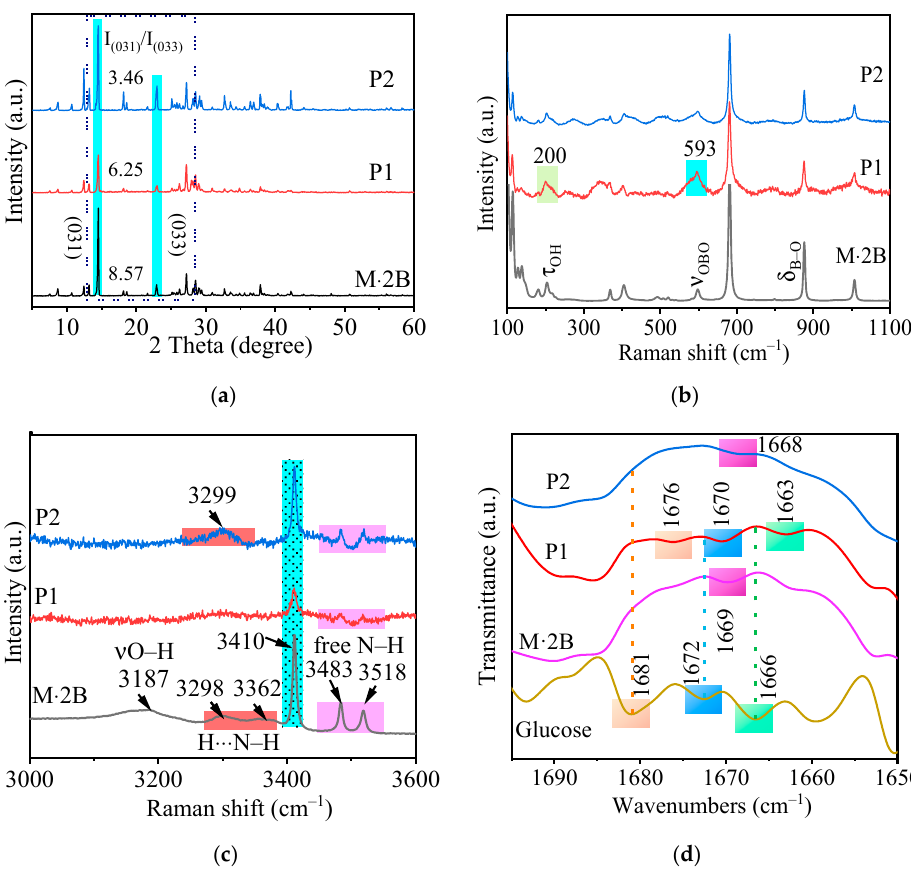
Figure 1. ( a ) Powder XRD patterns. ( b , c ) Raman spectra in the different wavenumber range. ( d ) An enlarged view of the FTIR spectra in the range of 1700~1650 cm − 1 for glucose, M·2B, P1, and P2.